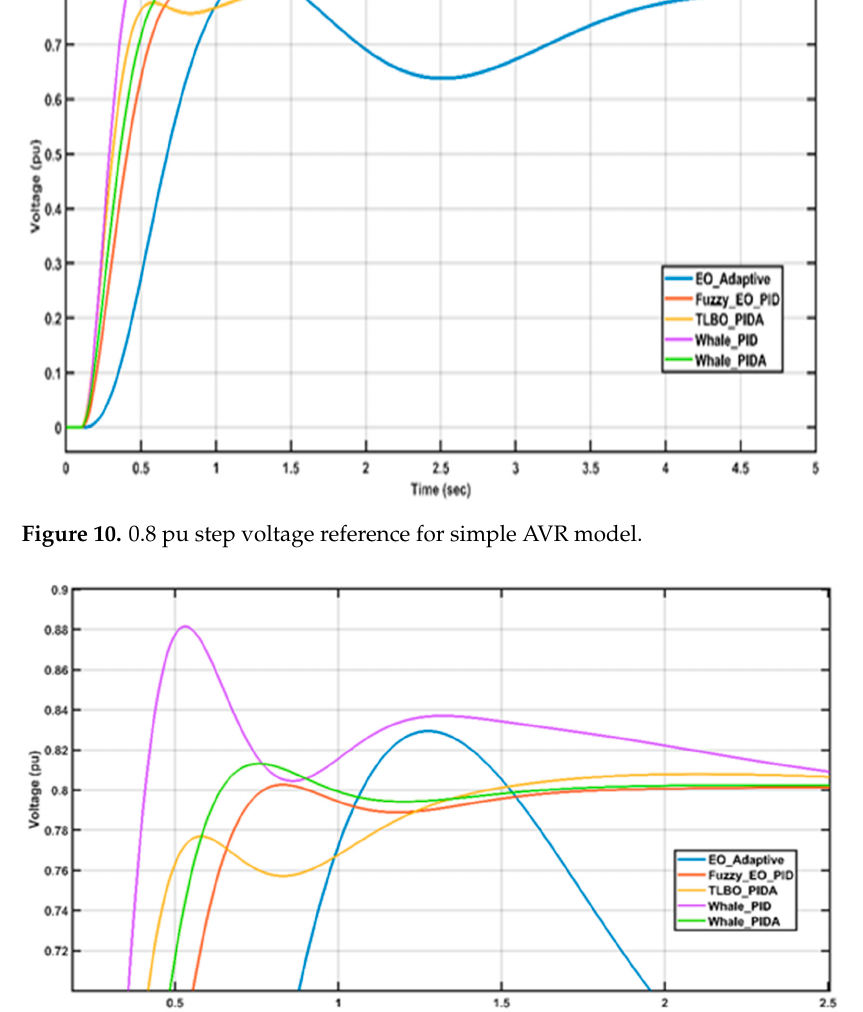
Figure 11. Focusing on the 0.8 pu step voltage reference case.